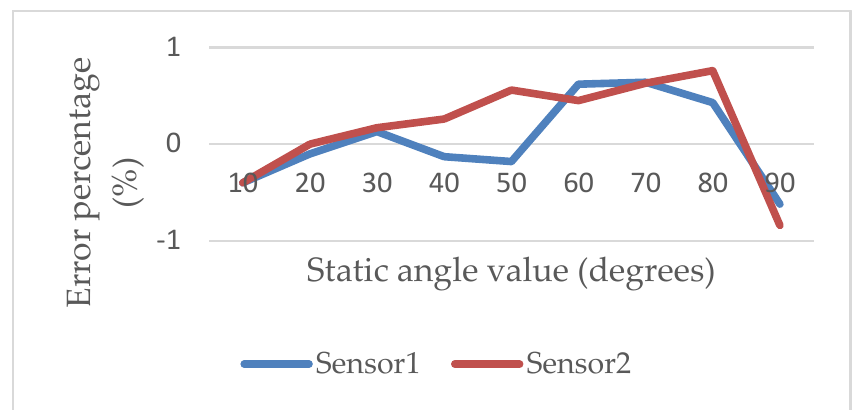
Figure 4. Deviation from 0 to 90 degrees in the ROMSS.